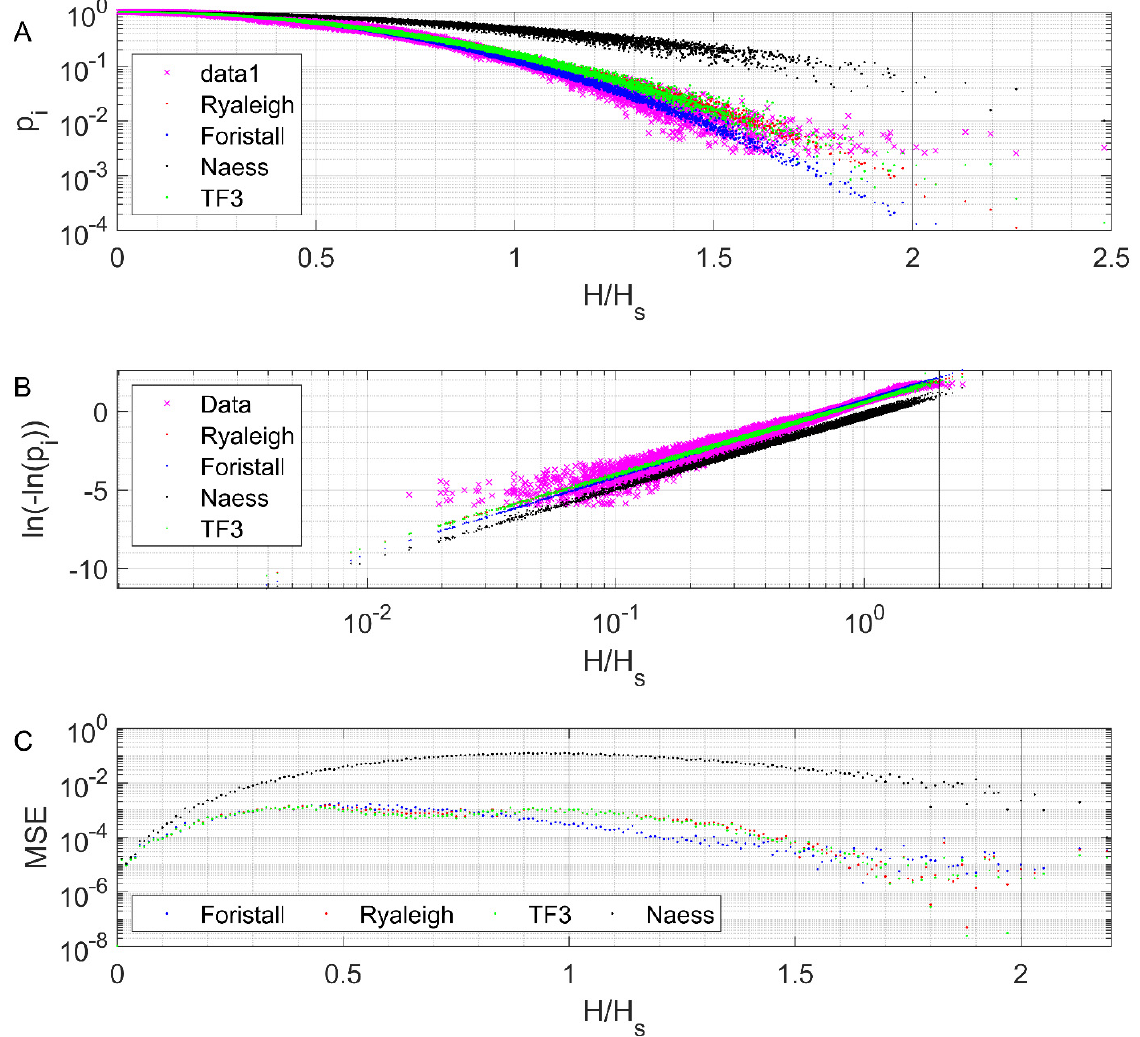
Figure 7. ( A ) Models fit comparison of the cumulative wave height distributions for the high sea event of 4–9 December 2017; ( B ) Linear models fit comparison of the cumulative wave height distributions for the high sea event of 4–9 December 2017; ( C ) Mean square error of the cumulative wave height distributions for the high sea event of 4–9 December 2017.